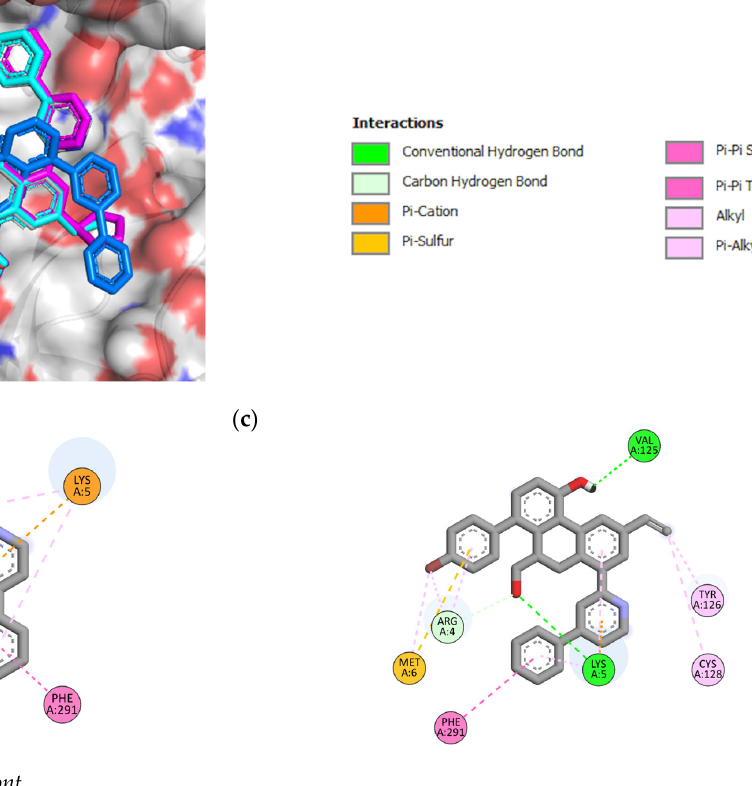
Figure 5. 3D representation of superimposition of the binding poses within the DIS of SARS-CoV-2 of 49 , 49n , 49p , and 49x molecules in white, cyan, magenta and blue color respectively ( a ); 2D representation of interactions within the DIS of SARS-CoV-2 Mpro of 49 ( b ), 49n ( c ), 49p ( d ), and 49x ( e ) molecules.